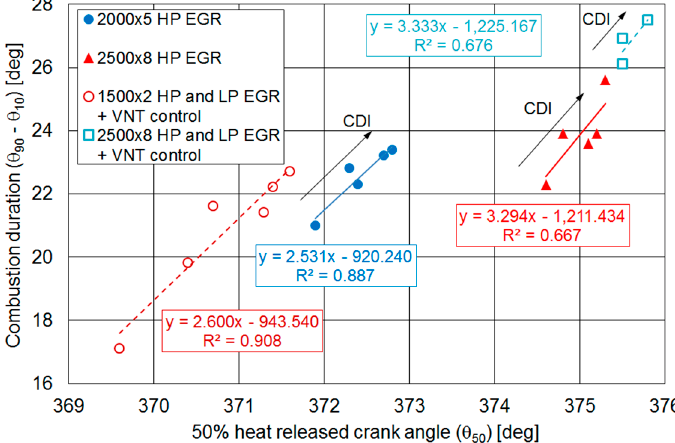
Figure 13. Link between 50% heat released crank angle and combustion duration in different test sets.